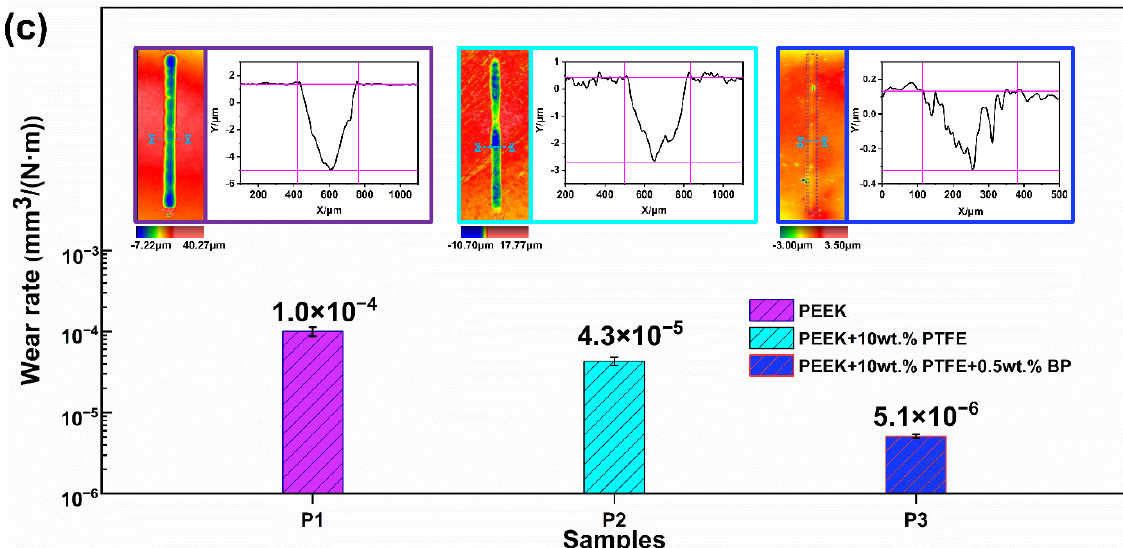
Figure 5. The friction coefficients and wear rates of the samples. ( a ) Variation curves in the COFs as a function of time for three samples; ( b ) The average COFs of three samples; ( c ) The wear rates of three samples.